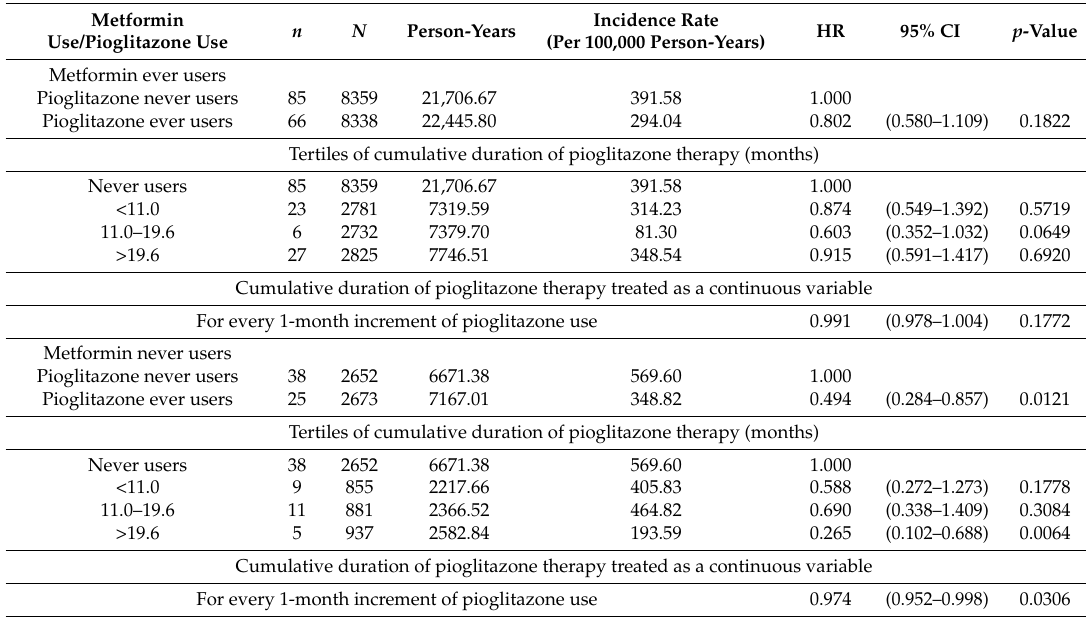
Table 3. Subgroup analyses with regards to metformin use for incidence rates and hazard ratios of dementia by pioglitazone